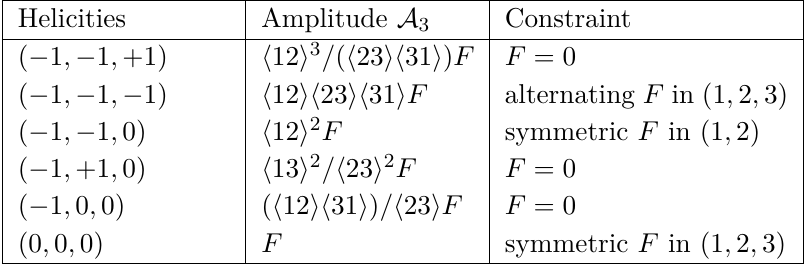
Table 1. Constrains on the three-particle amplitudes in a theory of a scalar coupled to a photon.